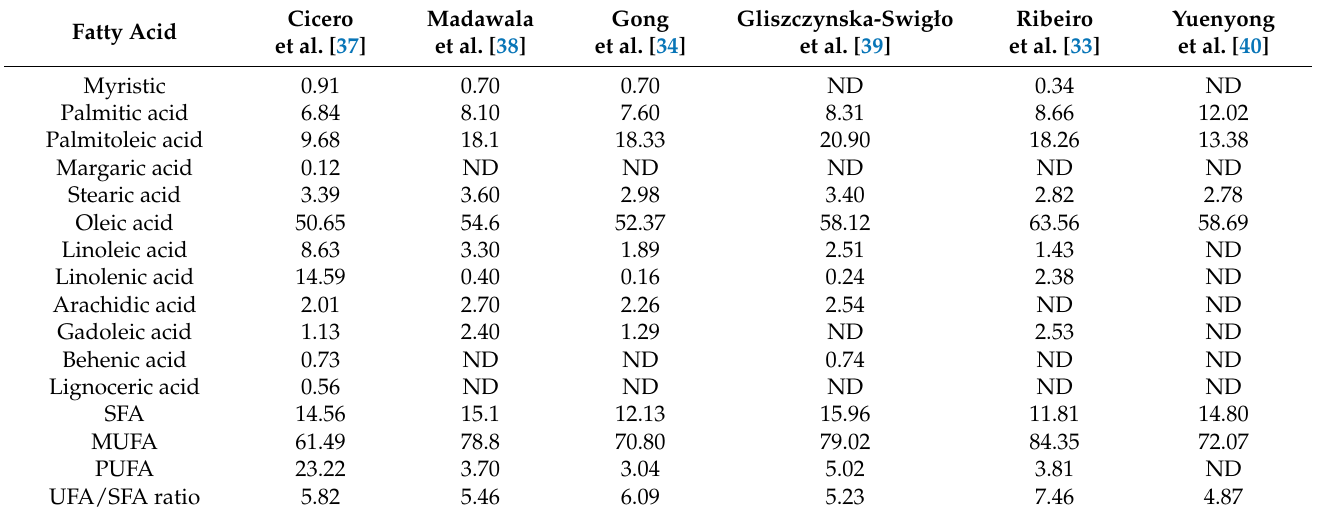
Table 1. Fatty acid composition (%) of cold-pressed macadamia nut